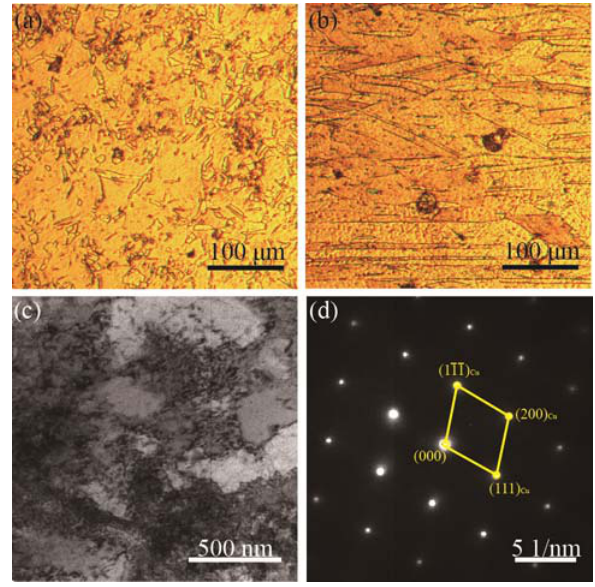
Figure 2. Microstructure of cold ‐ drawn Cu–Cr–In alloy. ( a ) Cross ‐ sectional morphology, ( b ) vertical section morphology and ( c ) TEM micrographs, ( d ) SADP of (c) with [011] Cu zone axis.